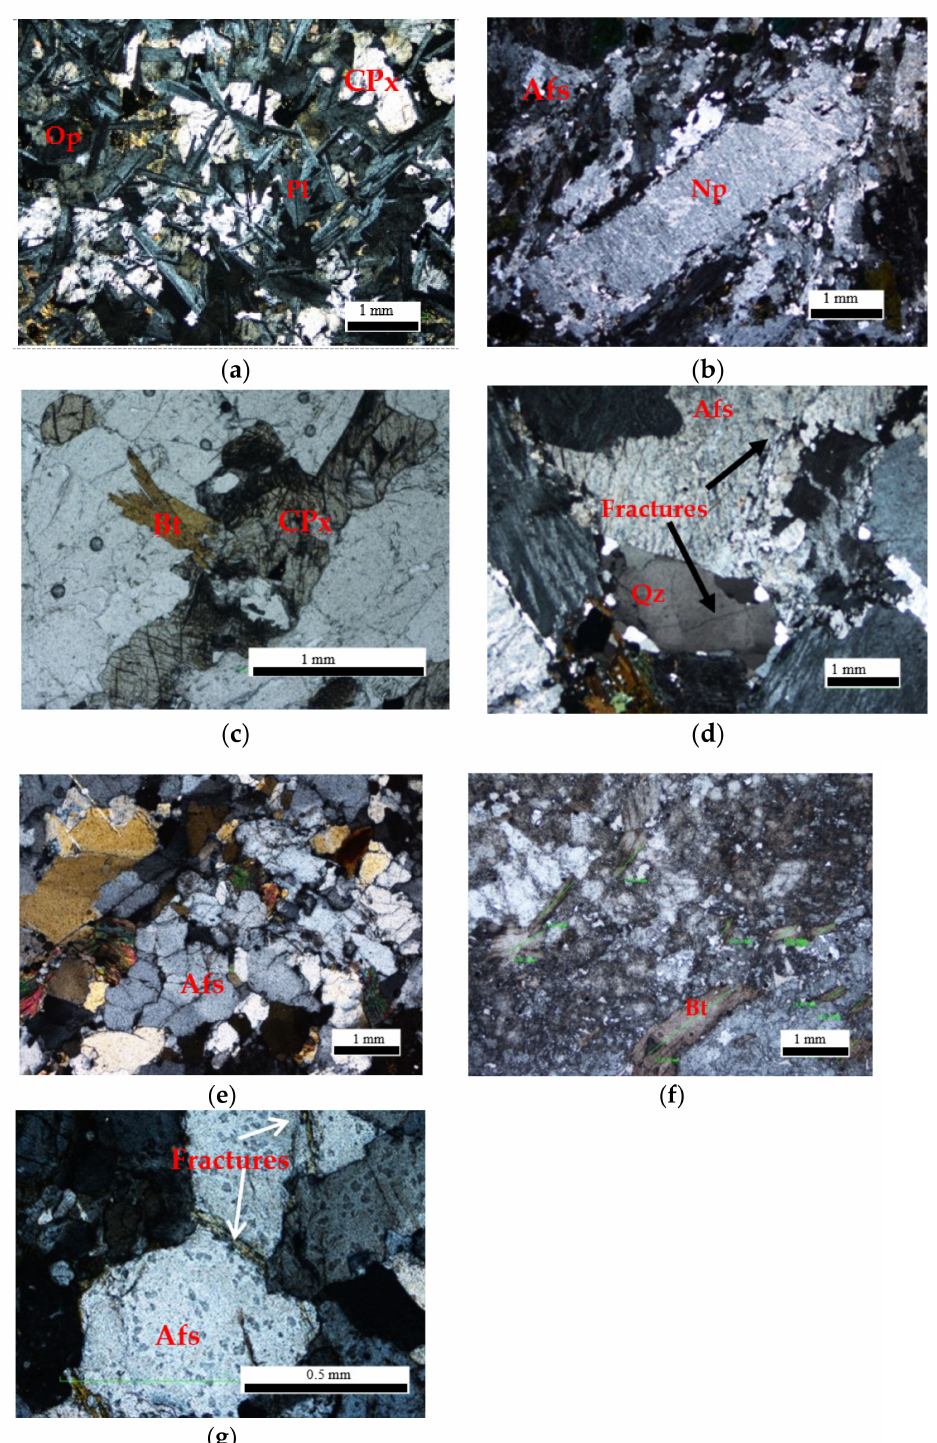
Figure 3. Microphotographs of the investigated rocks. Afs = alkali feldspar, Qz = quartz, Pl = plagioclase, Bt = biotite, Opq = opaque minerals, Nph = nepheline, CPx = clinopyroxene. ( a ) Ophitic texture of dolerite (sample UD). ( b ) Tabular phenocryst of nepheline (sample ANS). ( c ) Biotite crystallized along Cpx margins (sample CGN). ( d ) Fractures in feldspar and quartz (Sample AG). ( e ) Highly-fractured alkali feldspar and quartz (sample CGB). ( f ) Alignment of mica minerals (sample SG). ( g ) Fracture in feldspar (sample